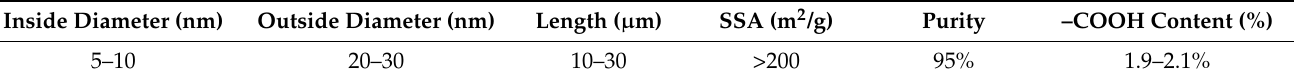
Table 1. Carboxyl-functionalized CNT properties.